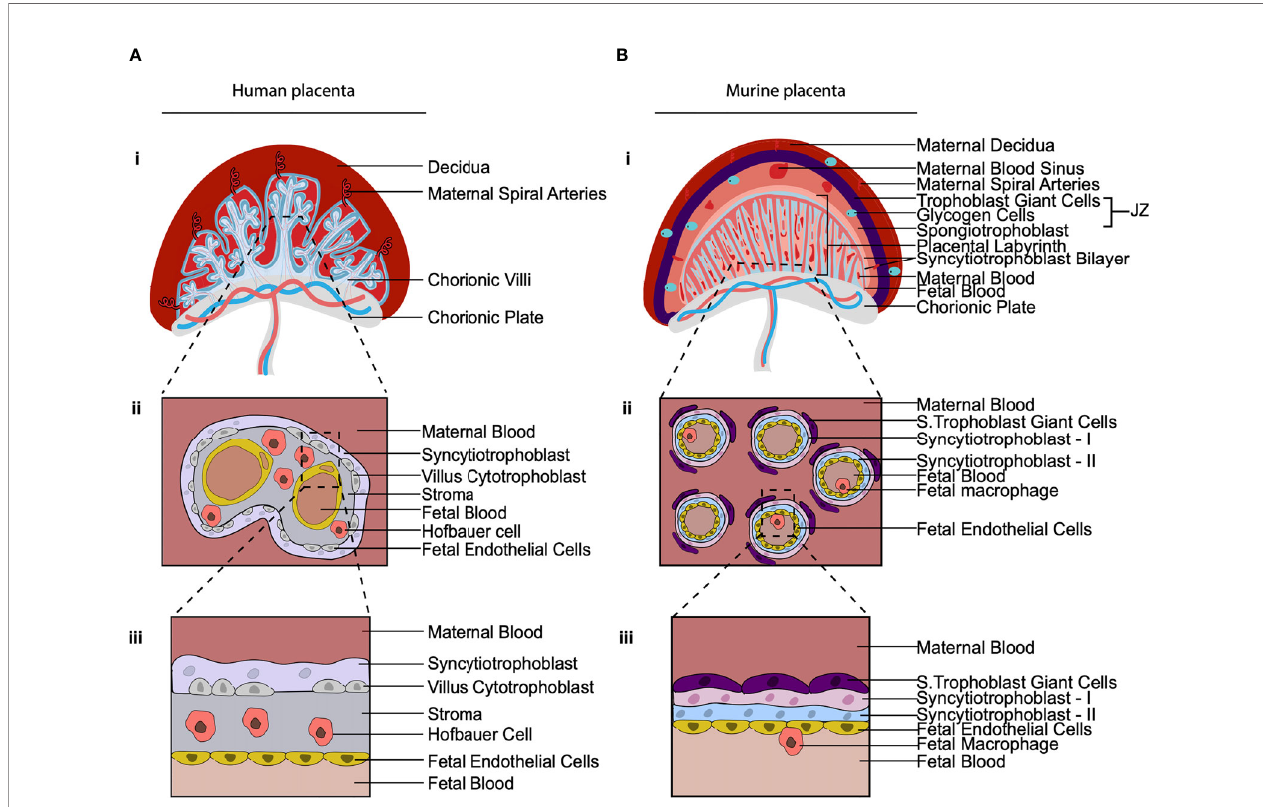
FIGURE 3 | The cellular composition of the human and murine placenta. (A, B) Illustration of 2 nd trimester human placenta (A) and murine placenta (B) . (i) Both have a discoid shape and are hemochorial (bathed in maternal blood). (ii) Cross section of the placental villus region. The human placenta is hemo(mono)chorial (one layer of trophoblast separates fetal and maternal blood). The murine placenta is hemo(tri)chorial (three layers of trophoblast separate fetal and maternal blood; syncytiotrophoblasts-I, syncytiotrophoblasts-II and sinusoidal trophoblast giant cells). (iii) Close up of the hemochorial barrier separating fetal and maternal blood. In the human placental HBC are found within the stroma between trophoblast and fetal endothelial. In the murine placenta, macrophages have been found in the placental blood vessels. JZ, Junctional Zone; S. Trophoblast Giant Cells, Sinusoidal Trophoblast Giant